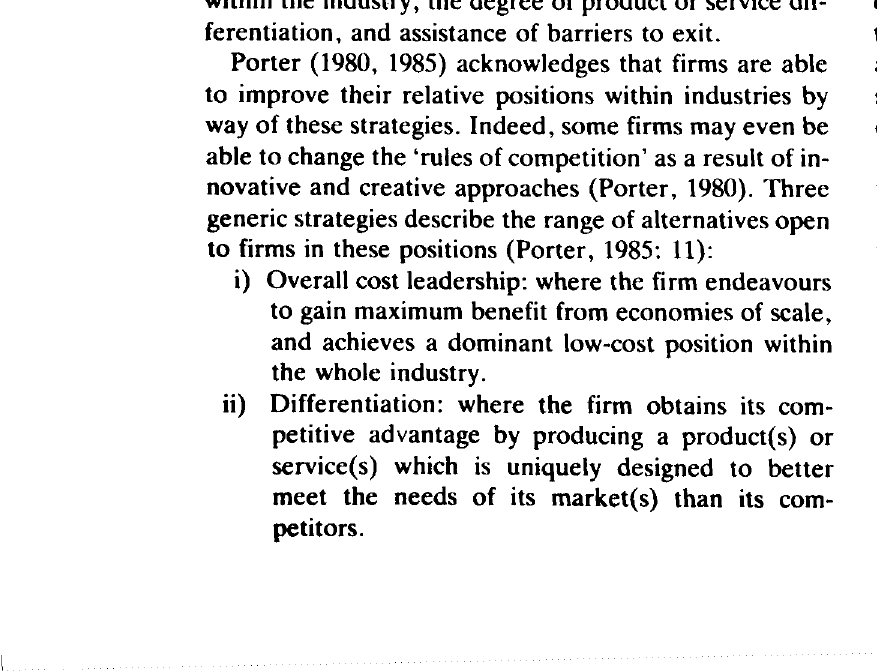
greater the buyers bargaining power, the better their ability to derive increases in value-for-money, either by depressing prices, or by forcing quality improvement without corresponding price increases. Factors such as the buyers' size relative to the firms in the industry, would impact on their bargaining